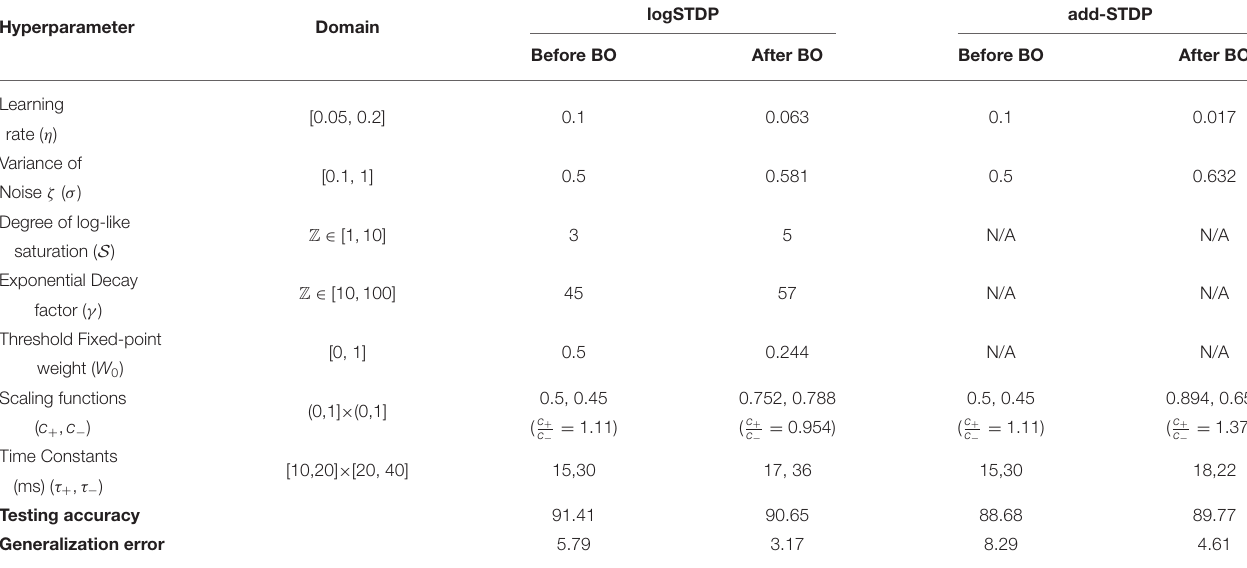
TABLE 5 | Table showing the set of hyperparameters used for the Bayesian optimization problem for the log-STDP process. logSTDP add-STDP Hyperparameter Domain Before BO After BO Before BO After